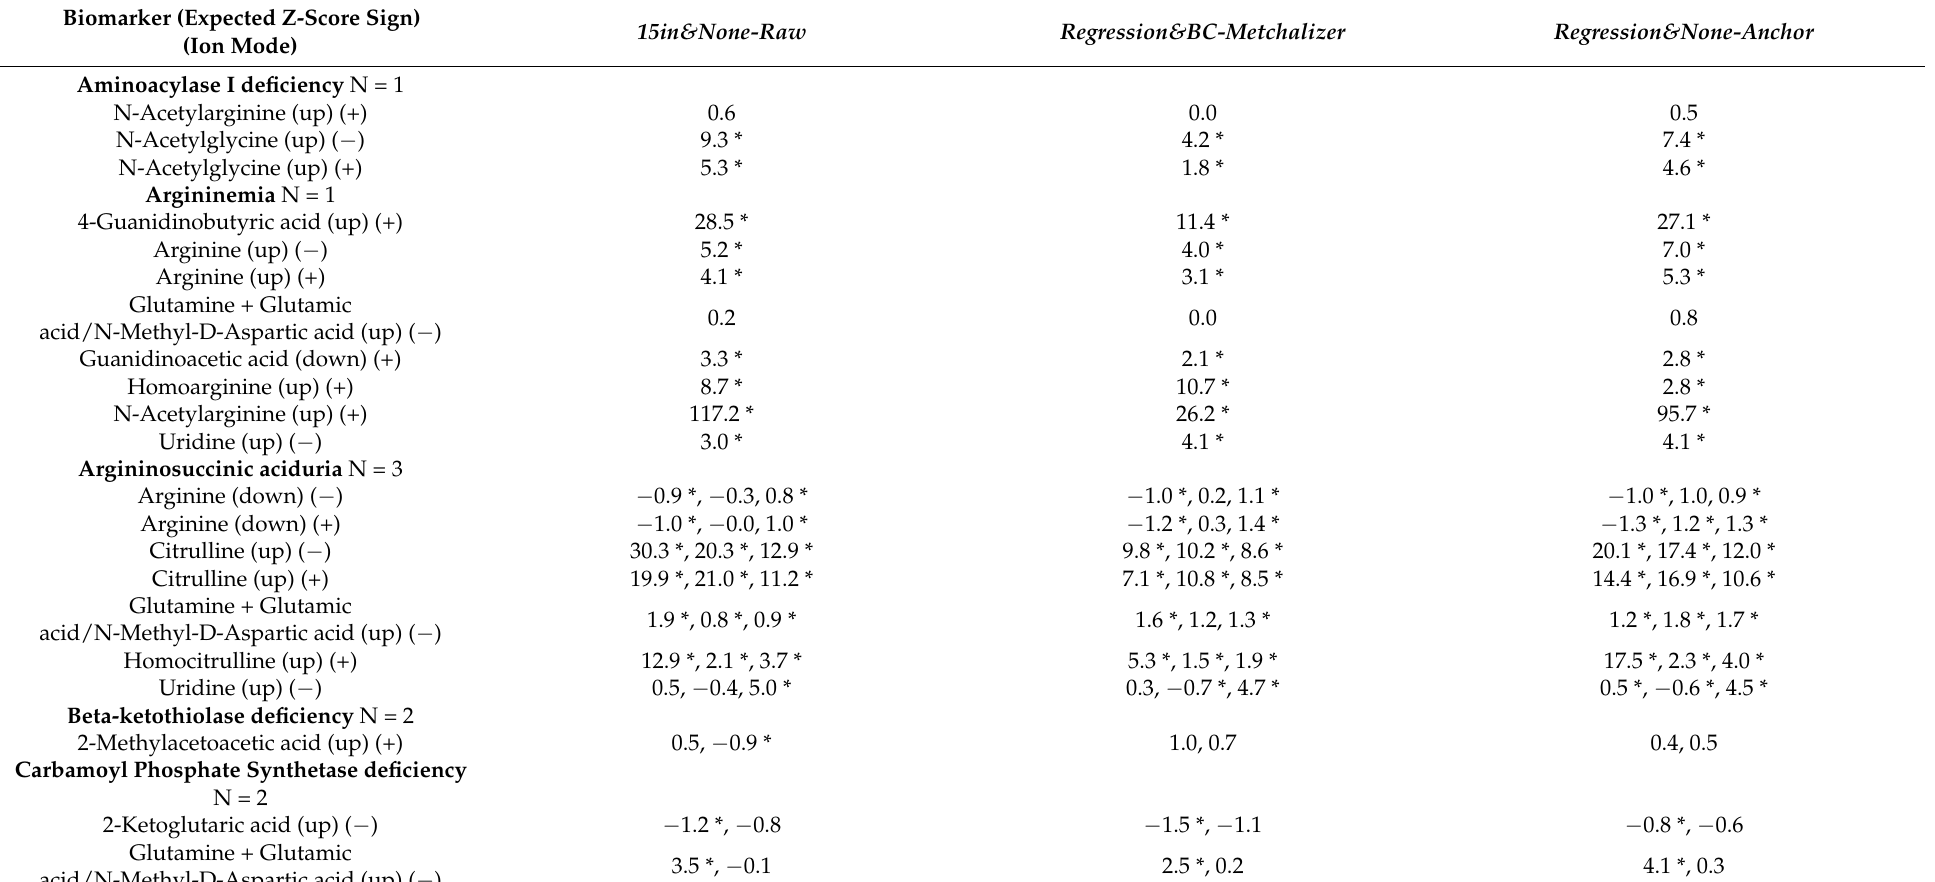
Table A6. Z-scores obtained from None-Raw&15in , BC-Metchalizer&Regression and None-Anchor&Regression per biomarker and IEM. The stars on the Z-scores indicate that Welch’s t -test p -values < 0.05. The amount of unique patients is indicated by N next to the name of the IEM. Biomarker (Expected Z-Score